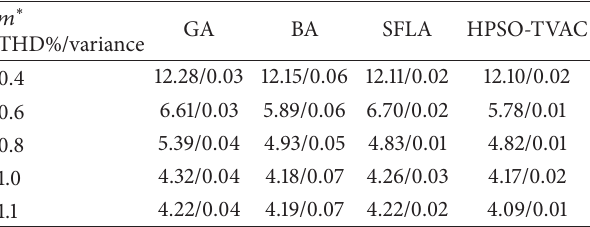
Figure 4: Structure of two-layer feed-forward network. Table 3: THD results and variance of THD in 10 times running at five operating